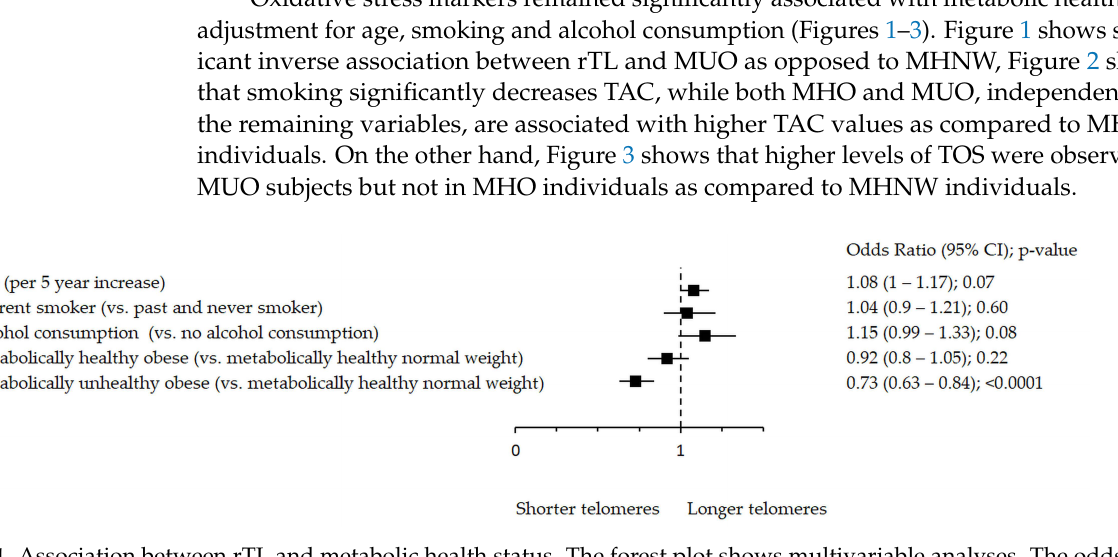
Figure 1. Association between rTL and metabolic health status. The forest plot shows multivariable analyses. The odds ratio with 95% confidence interval (CI) was obtained for precision and adjusted by age, smoking and drinking.